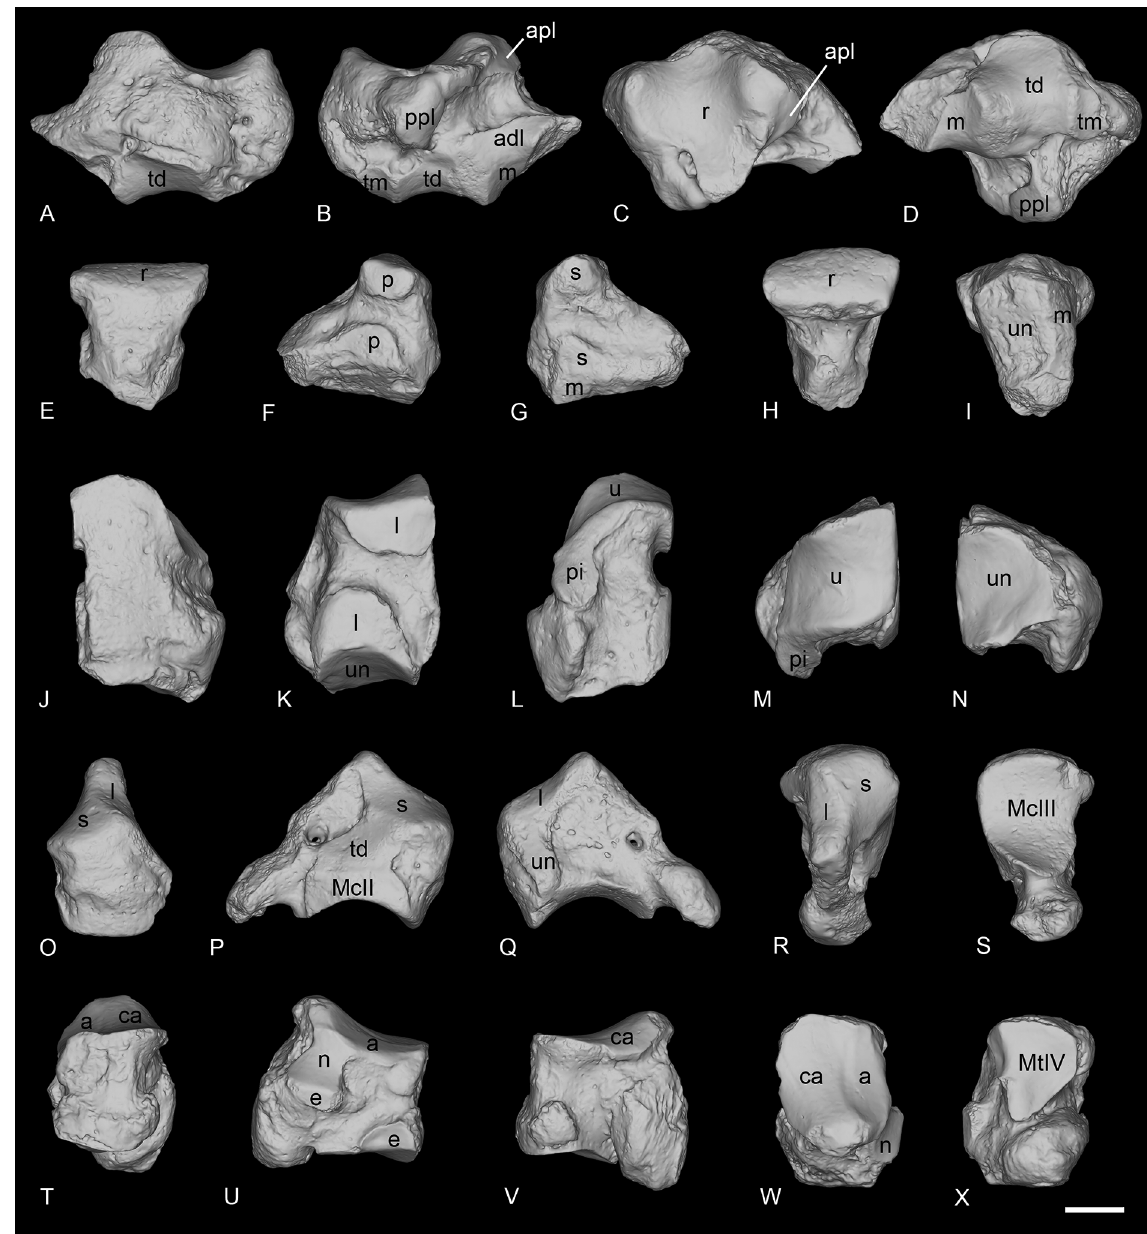
Fig. 13. ? Ronzotherium filholi (Osborn, 1900) from the Phosphorites du Quercy (early Oligocene?, France). – A–D . Right scaphoid NMB-QV-275. A . Medial view. B . Lateral view. C . Proximal view. D . Distal view. – E–I . Right lunate NMB-QE-440. E . Anterior view. F . Lateral view. G . Medial view. H . Proximal view. I . Distal view. – J–N . Left pyramidal NMB-QE-433. J . Anterior view. K . Medial view. L . Posterior view. M . Proximal view. N . Distal view. – O–S . Left magnum NMB-QE-472. O . Anterior view. P . Medial view. Q . Lateral view. R . Proximal view. S . Distal view. – T–X . Left cuboid NMB-QE-362. T . Anterior view. U . Medial view. V . Lateral view. W . Proximal view. X . Distal view. Abbreviations: a = astragalus; adl = anterodistal facet for the lunate; apl = anteroproximal facet for the lunate; ca = calcaneus; e = ectocuneiform; l = lunate; m = magnum; n = navicular; p = pyramidal; pi = pisiform; ppl = postero-proximal facet for the lunate; r = radius; s = scaphoid; td = trapezoid; tm = trapezium; u = ulna; un = unciform. Scale bar: 2